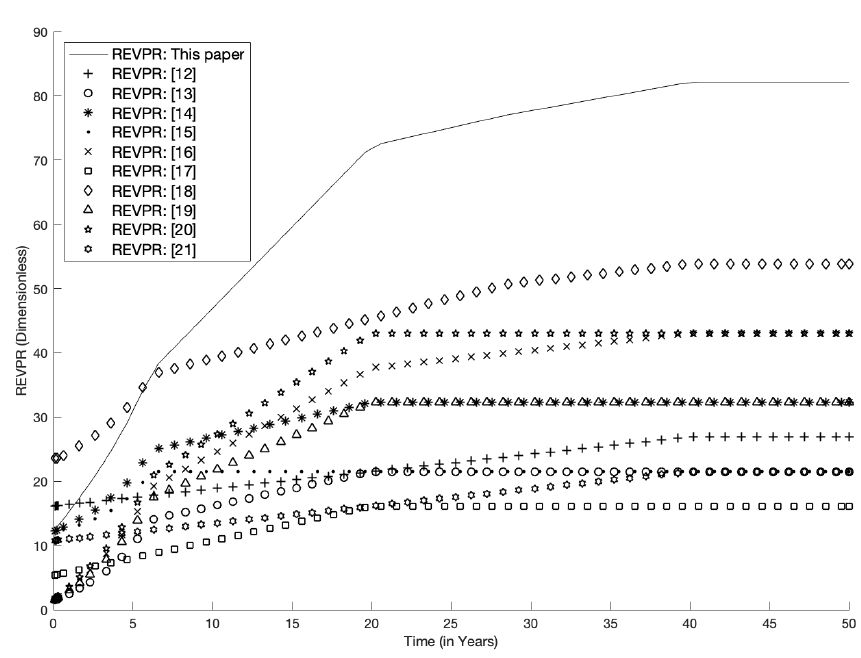
Figure 3. Relative EV Proliferation